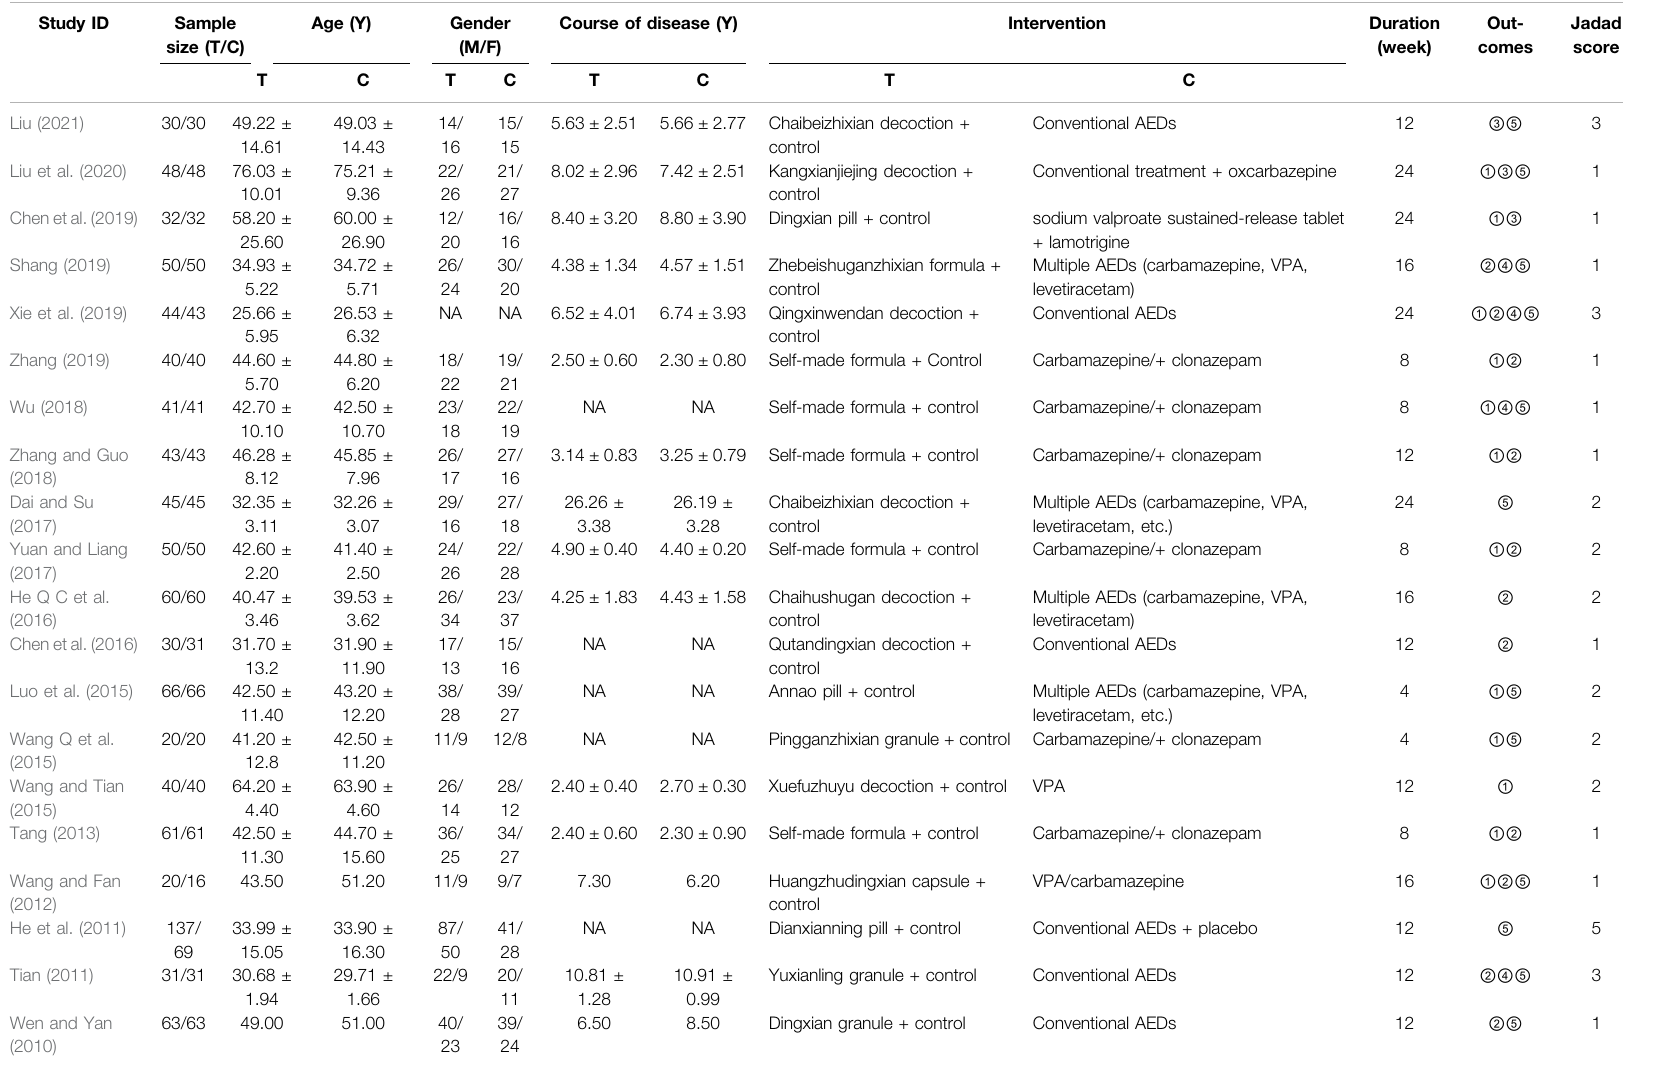
TABLE 1 | | Characteristics of the included RCTs and the detail of PICOS. Study ID